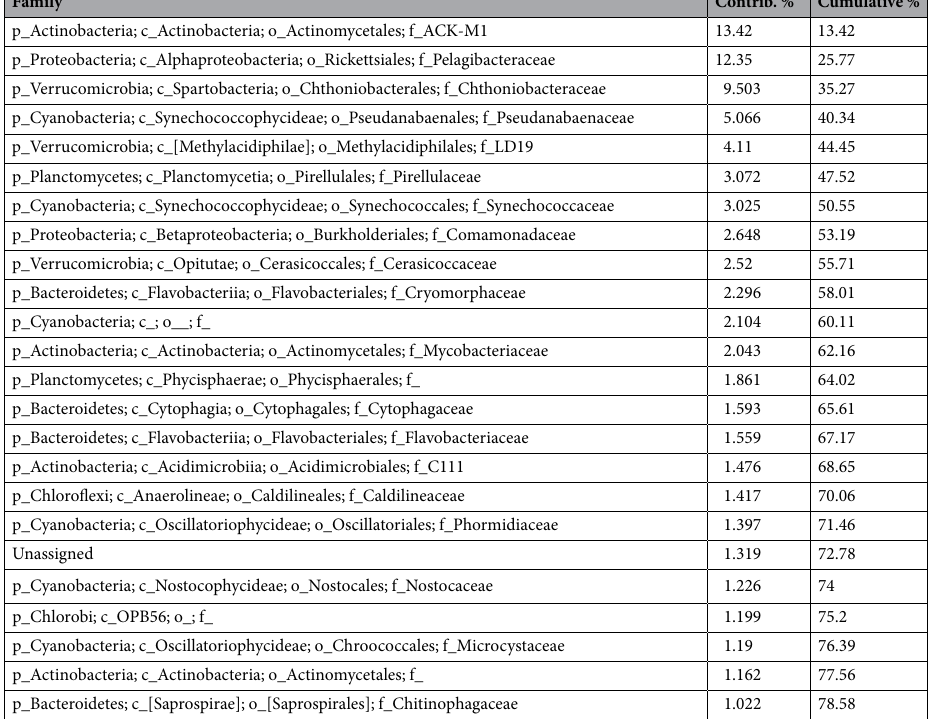
Table 2. The SIMPER test results of the contribution and cumulative percentage of families mainly responsible for the observed differences between groups of eutrophic (E; consisting of eight lakes, TSI from 56 to 60) and mesotrophic-eutrophic (ME; consisting of seven lakes, TSI from 40 to 53)